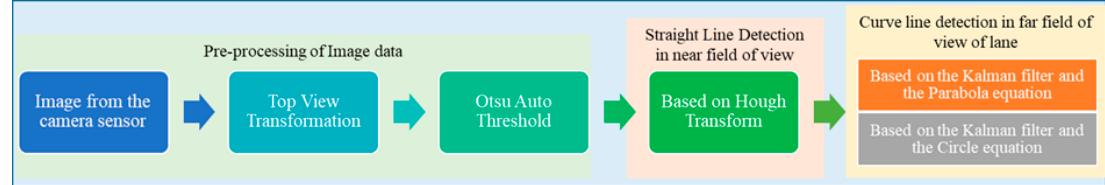
Figure 2. The flow diagram of the lane detection algorithms using the Kalman filter.